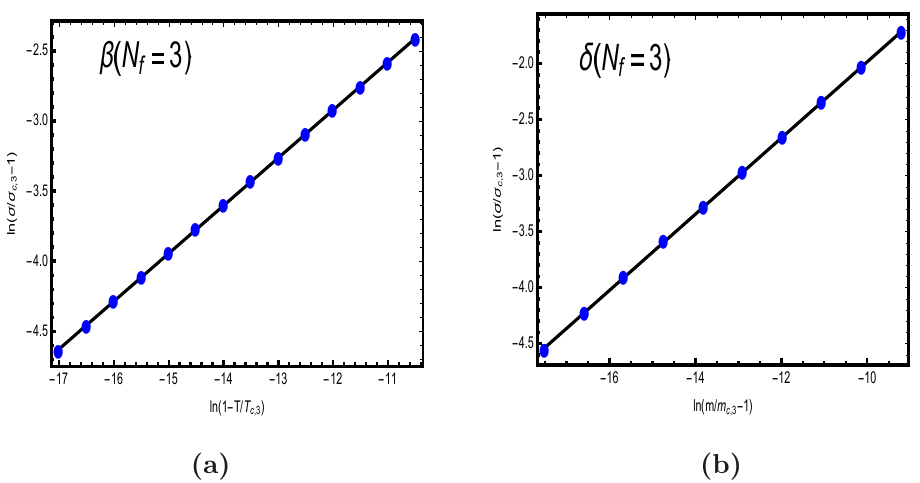
Figure 6 . Temperature and quark mass dependence of chiral condensate near the critical point T c, 3 = 0 . 1888GeV , m c, 3 = 0 . 036871 . . . GeV , σ c , 3 = 0 . 027 GeV 3 with three degenerate quarks. The dilaton filed is kept as that in eq. ( 2.2) and the scalar interaction takes the configuration v 3 = T 3 , v 4 = 8. Panel.(a) gives ln( σ − σ c, 3 ) as a function of ln(1 ), with fixed quark mass m = σ c, 3 T c, 3 − − m c, 3 = 0 . 036871 . . . GeV. The blue dots are model calculation and the black solid straight line are linear fitting of the dots, which has the form y = 1 . 165 + 0 . 340 x . Panel.(b) gives ln( σ − σ c, 3 ) as a σ c, 3 function of ln( m − m c, 3 ). The blue dots are model calculation and the black solid straight line are m c, 3 linear fitting of the dots, which has the form y = 1 . 417 + 0 . 340 x